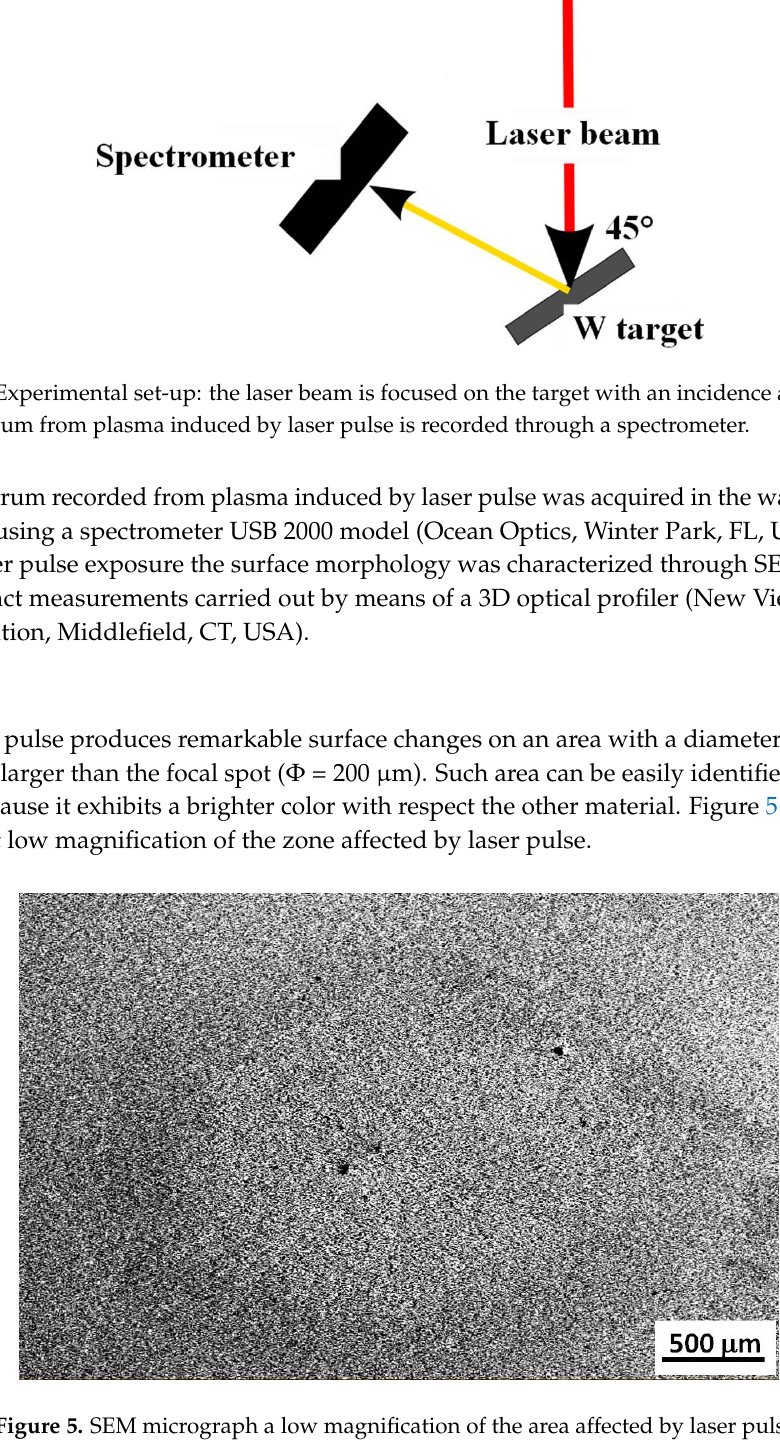
Figure 5. SEM micrograph a low magnification of the area affected by laser pulse.